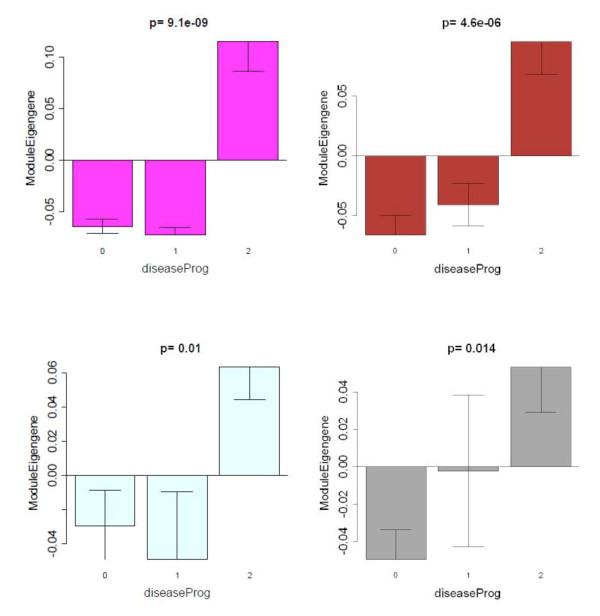
Identification of primary Sjögren's syndrome disease-related gene modules revealed by weighted gene co-expression network analysis. Barplots showing the mean value of the module eigengene (y axis) versus human disease progression status (x axis) where 0 denotes healthy controls, 1 denotes nonprimary Sjögren's syndrome (non-pSS) sicca patients, and 2 denotes pSS patients. Kruskal-Wallis test P values above the plots show that the module eigengenes of all four modules - Magenta (576 genes), Brown (2,502 genes), Grey60 (216 genes), and Light-Cyan (349 genes) - are significantly overexpressed in pSS patients compared with both non-pSS sicca patients and controls.